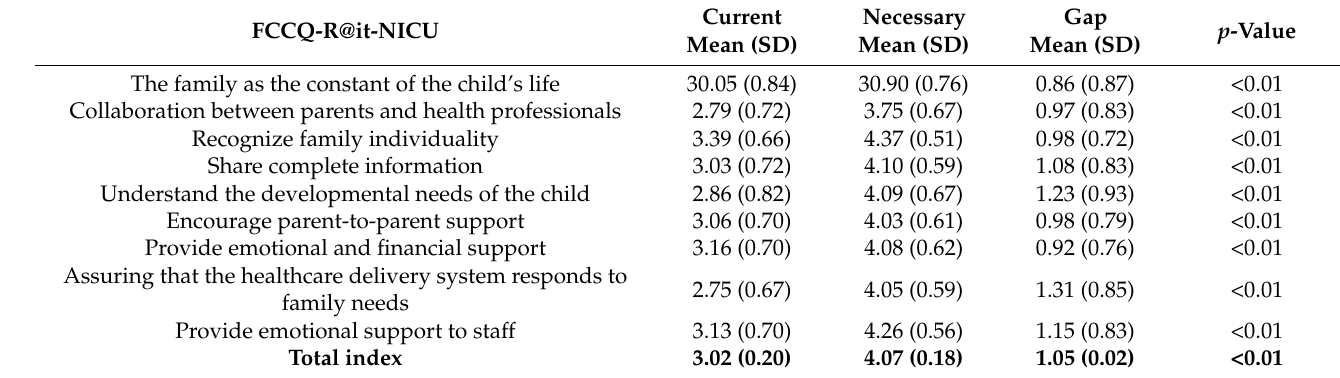
Table 4. Gap between Current and Necessary FCCQ-R@it-NICU sub-scales.